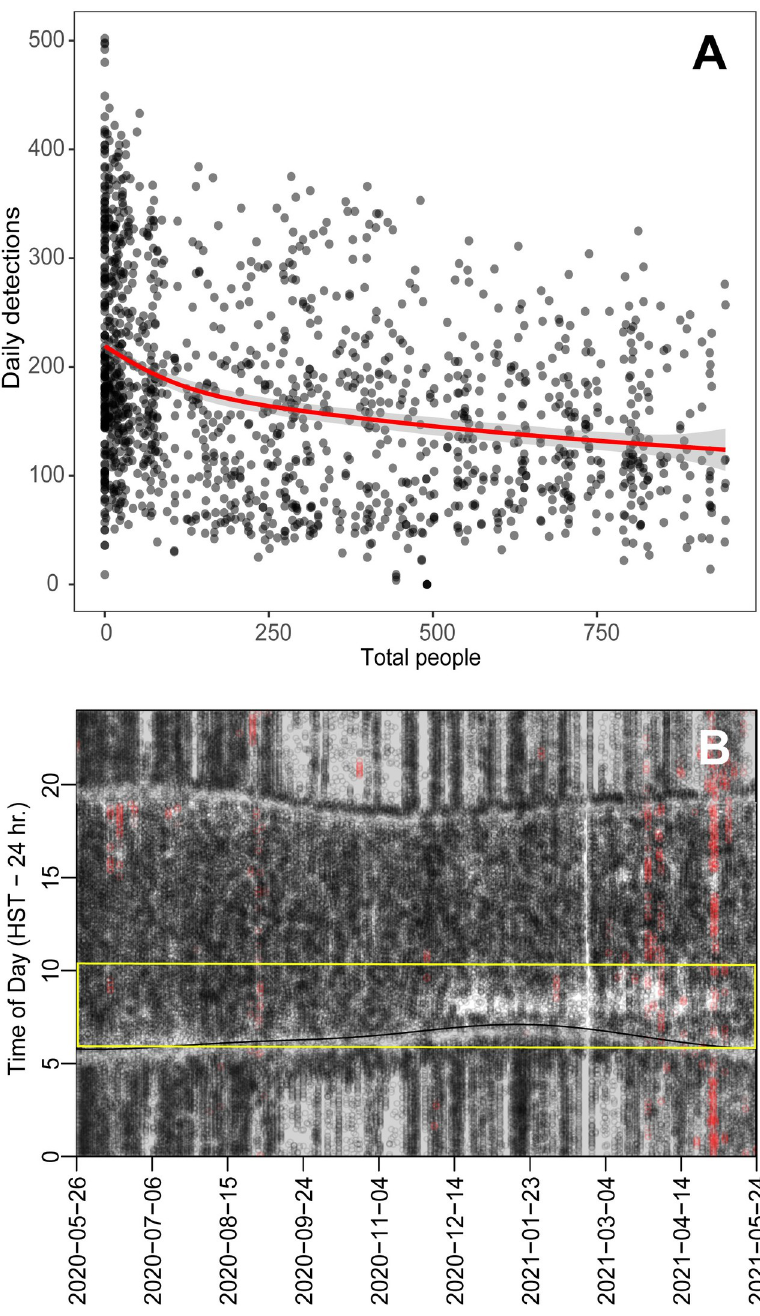
Fig 4. (A) Fish detections vs. presence of people at Molokini. Grey dots show detections per day for all Caranx melampygus vs. the daily count of people visiting the crater, with darker shade showing higher density. Red line shows GLM fit, grey envelope shows 95% confidence interval. (B) Diel behavior one C . melampygus (44 cm fork length) during 2020 and 2021. Y-axis shows diel cycle with time 00:00 (start of diel cycle) at bottom, noon at center and time 23:59 (end of diel cycle). Horizontal curves show dawn and dusk respectively. Dots show detections of C . melampygus with black representing inside the crater and red outside the crater. Yellow box indicates morning period of high human abundance. An interpretation guide for this figure is provided in the S1 Fig in S1 File.